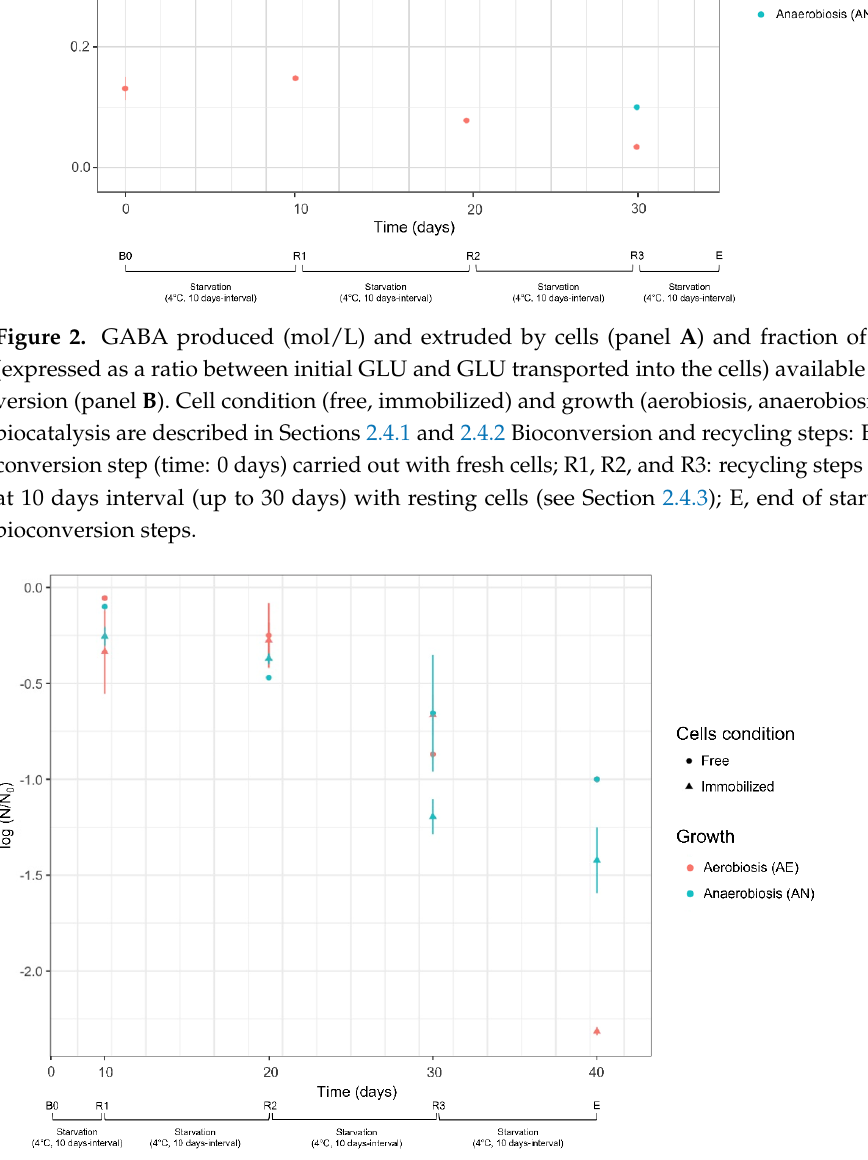
Figure 3. Survival of Lvb. brevis LB12 during starvation cycles (4 °C, 10 day intervals). Survival was expressed as the reduction of log N/N 0 , where N 0 and N are the respective number of cells at the beginning and at the end of each starvation step (t0–t10 for R1; t10–t20 for R2, t20–t30 for R3). Cell condition (free, immobilized) and growth (aerobiosis, anaerobiosis) used for biocatalysis are described in Sections 2.4.1 and 2.4.2. Bioconversion and recycling steps: B0, first bioconversion step